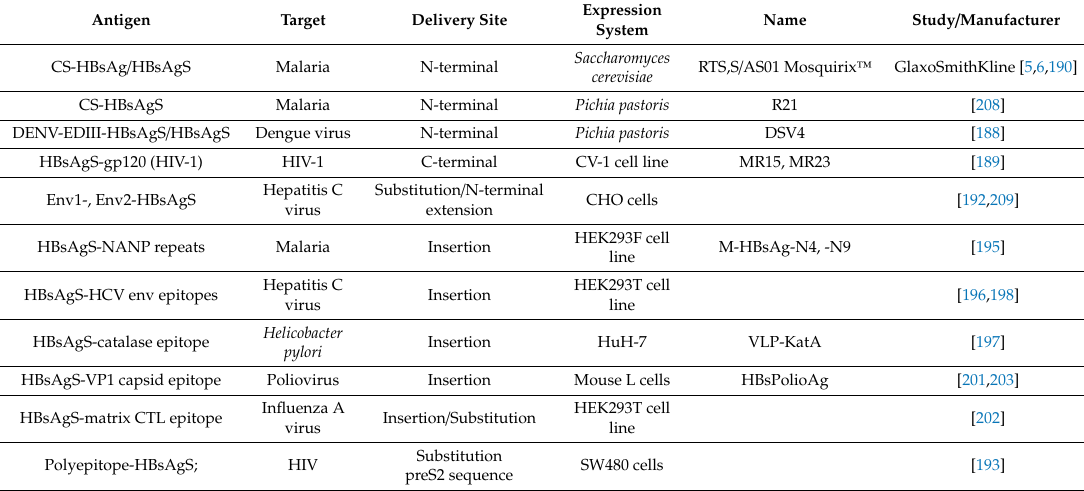
Table 2. Selection of chimeric HBsAg SVP platforms and